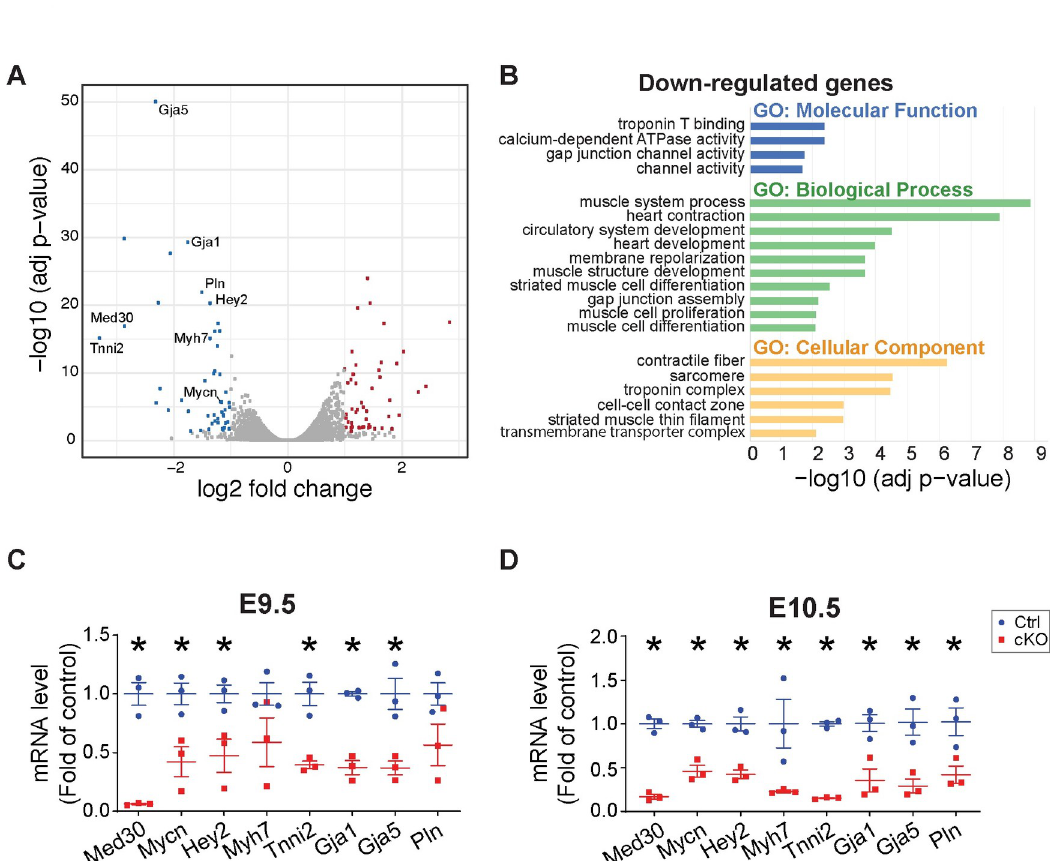
Fig 3. Transcriptome analysis in Med30 cardiomyocyte-specific knockout (cKO) and control (Ctrl) hearts. ( A ) Volcano plot obtained from DESeq2 analysis of gene expression in Med30 cKO versus control hearts at E10.5. Genes with adjusted P < 0.05 and log2 (fold change) > 1 are considered significantly upregulated or downregulated genes in Med30 cKO hearts. The upregulated or downregulated genes are highlighted in red and blue, respectively. (B) Gene Ontology (GO) analysis of significantly downregulated genes in Med30 cKO hearts. (C, D) qRT-PCR validation of RNA-seq data in Med30 cKO (red) versus control (Ctrl) (blue) hearts at E9.5 (C) and E10.5 (D). Data were normalized to corresponding 18s levels, and cKO is expressed as the fold-change versus control. n = 3. Data are represented as the mean ± SEM. � P < 0.05, by 2-tailed Student’s t